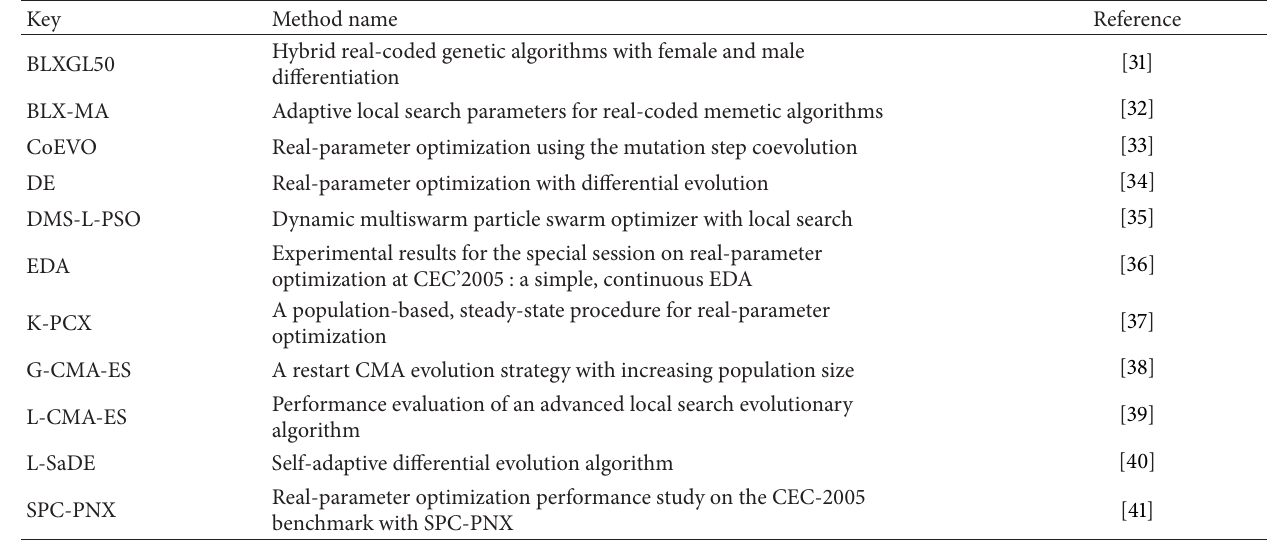
Figure 9: The box plots for showing the effect varying HMS values using the ten global optimization functions. Table 2: Key to CEC’2005 comparative